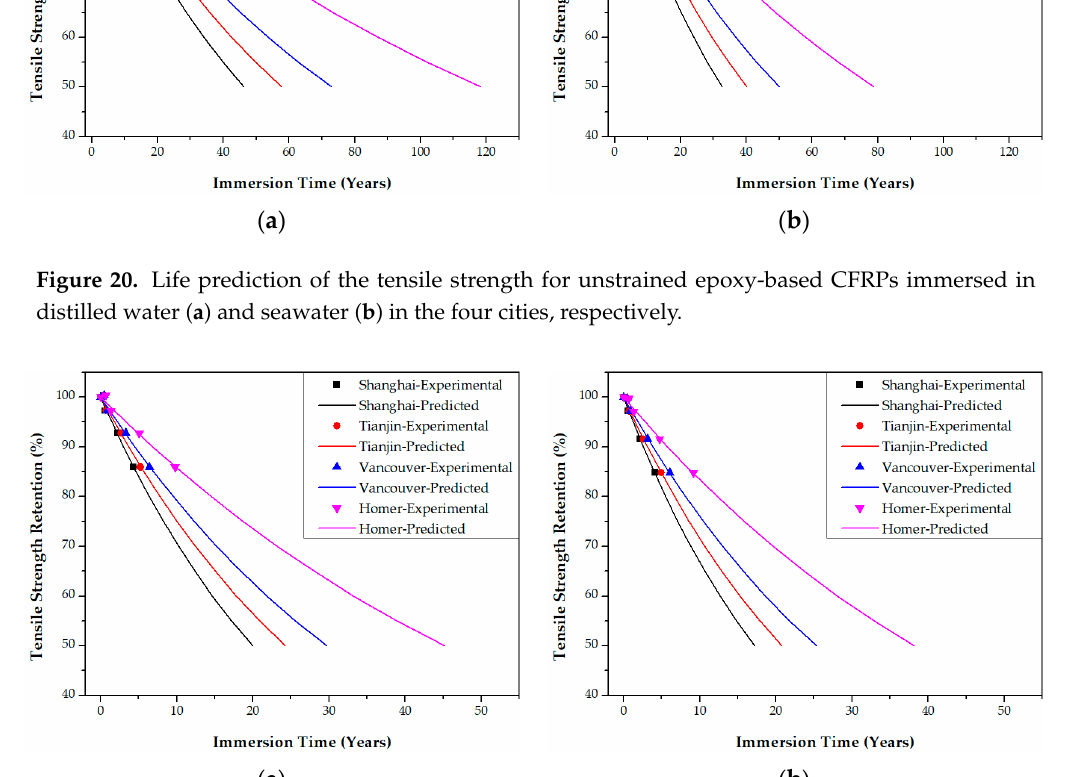
Figure 21. Life prediction of the tensile strength for epoxy-based CFRPs (30% strain) immersed in distilled water ( a ) and seawater ( b ) in the four cities, respectively.